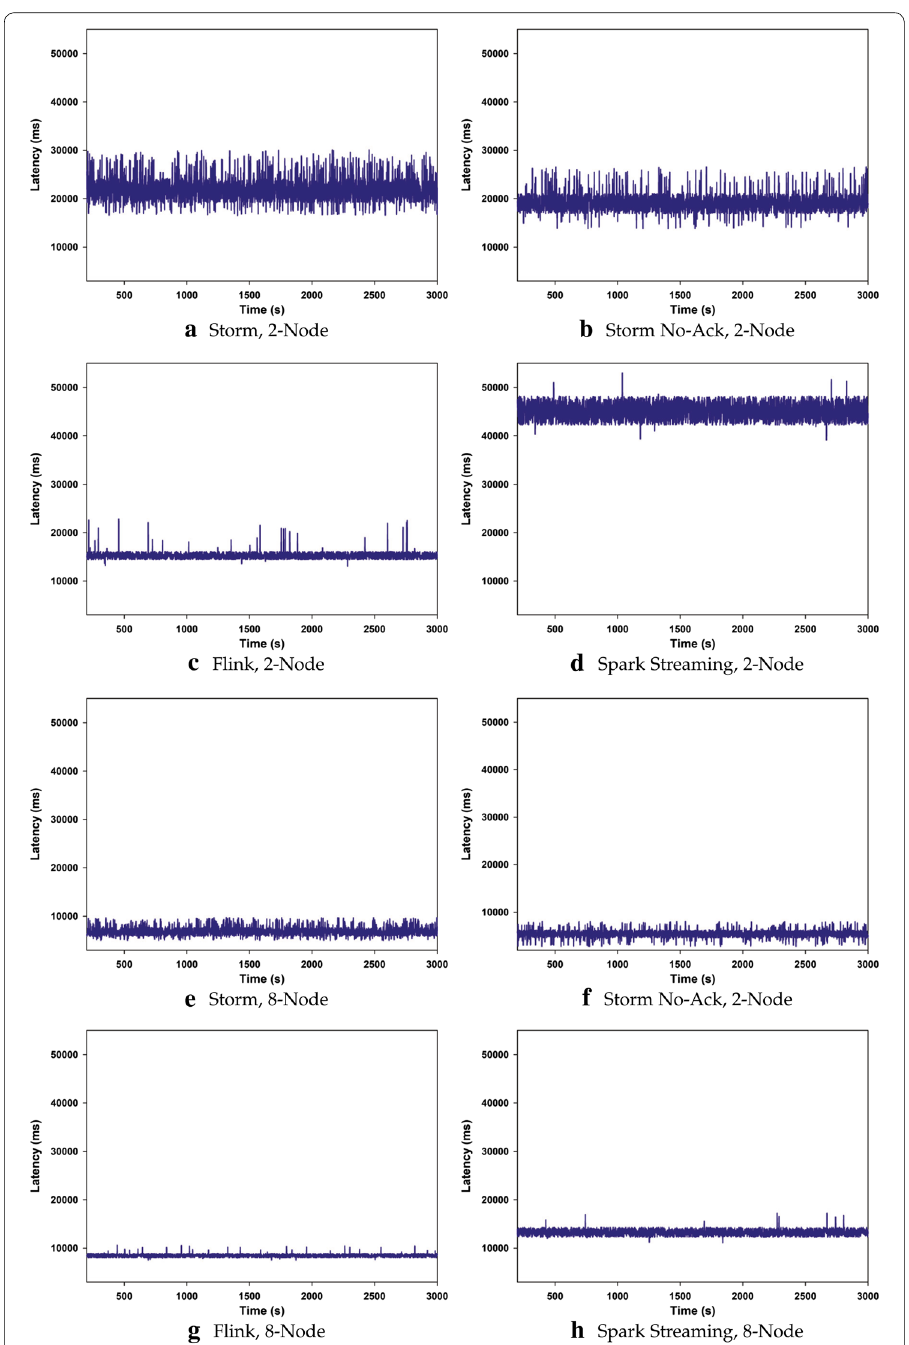
Fig. 12 Latency of intended frameworks with different number of worker nodes for Model Training Figures 13 and 14 represent the throughput of each framework over the time; using 2 and 8 worker nodes. In these experiments, we have executed the applications by dif- ferent number of worker nodes with a particular input rate ( Advertising : 2.8 M tuple/s,